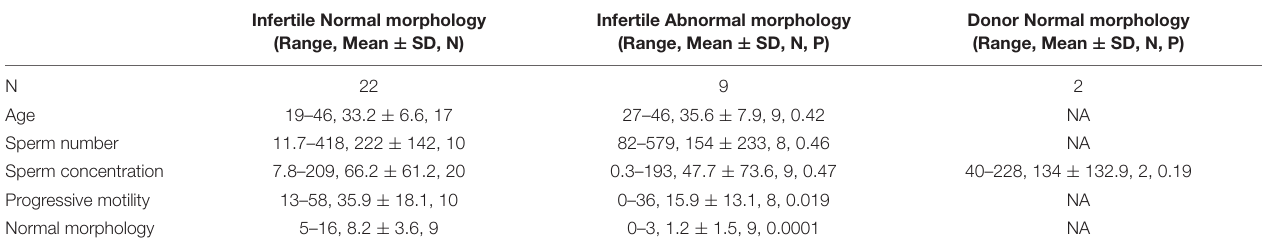
TABLE 1 | Summary of sperm characteristics from semen